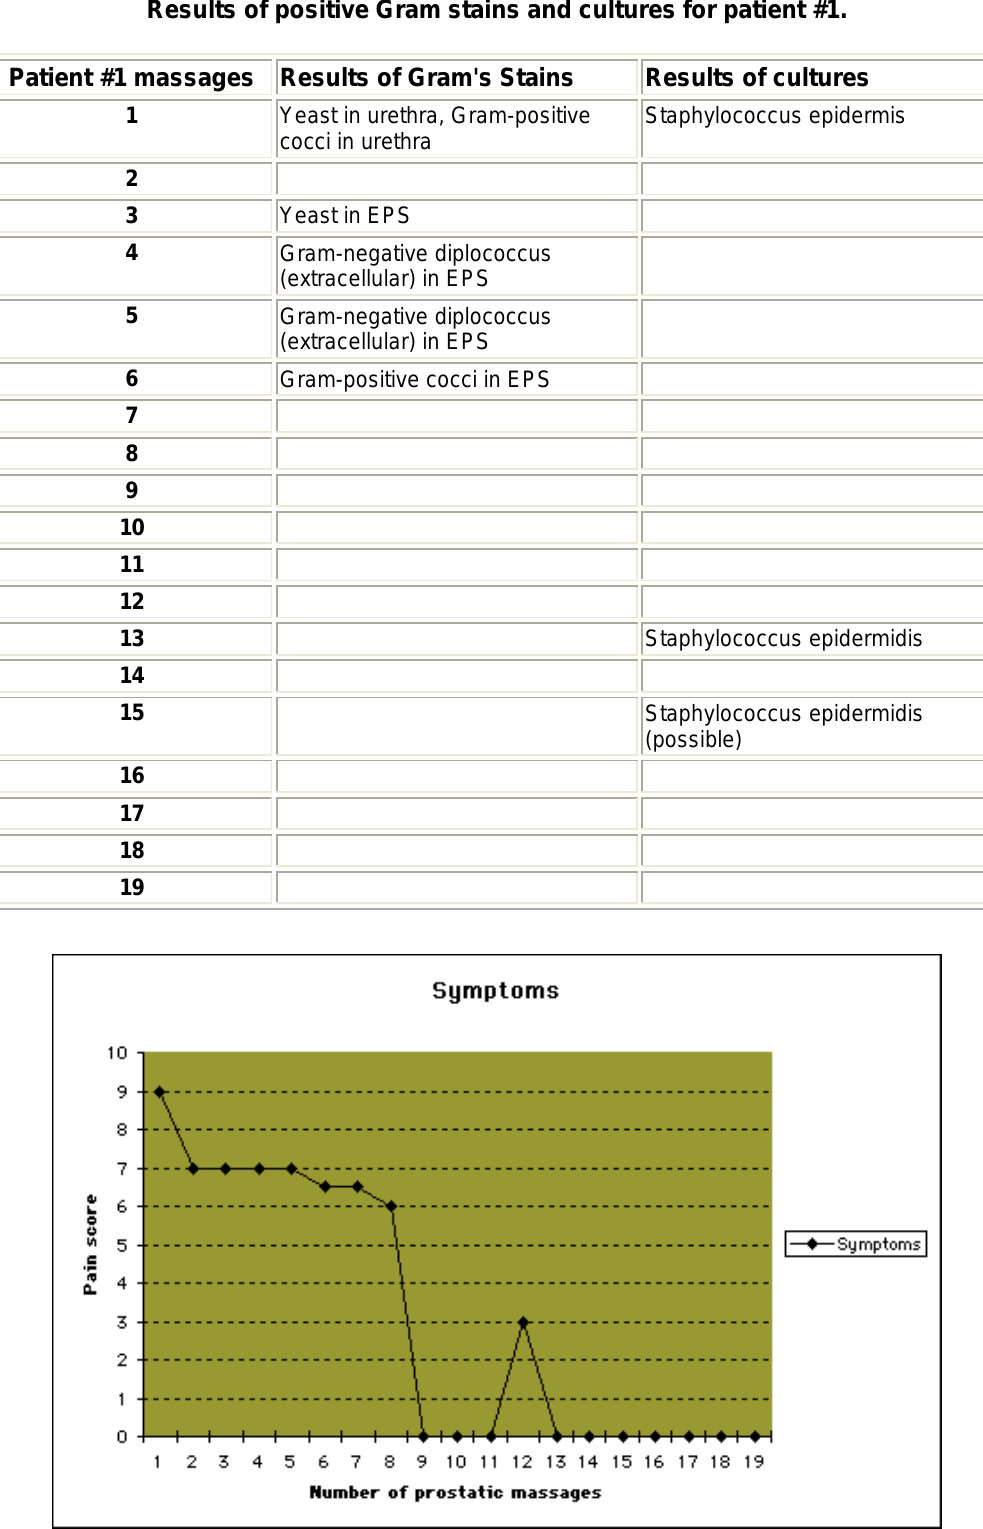
FIGURE 2 . The dropping pain score of patient #1 over 19 prostatic